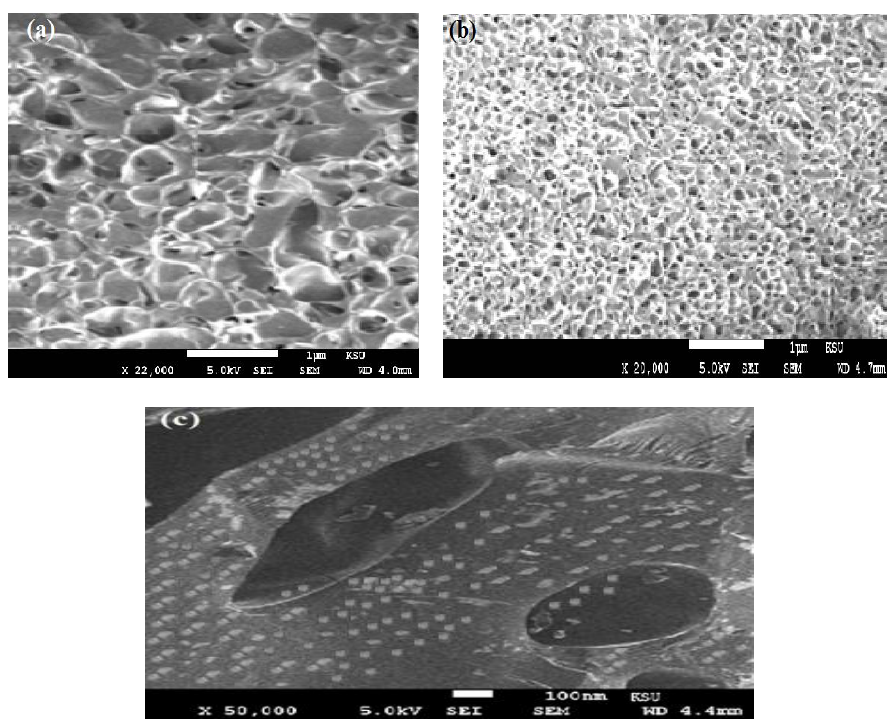
Figure 5. Transmission electron microscope (TEM) photos of ( a ) VS/AMPS, ( b ) Fe 3 O 4 ·VS/AMPS and ( c ) VS/AMPS·Fe 3 O 4 cryogel composites.